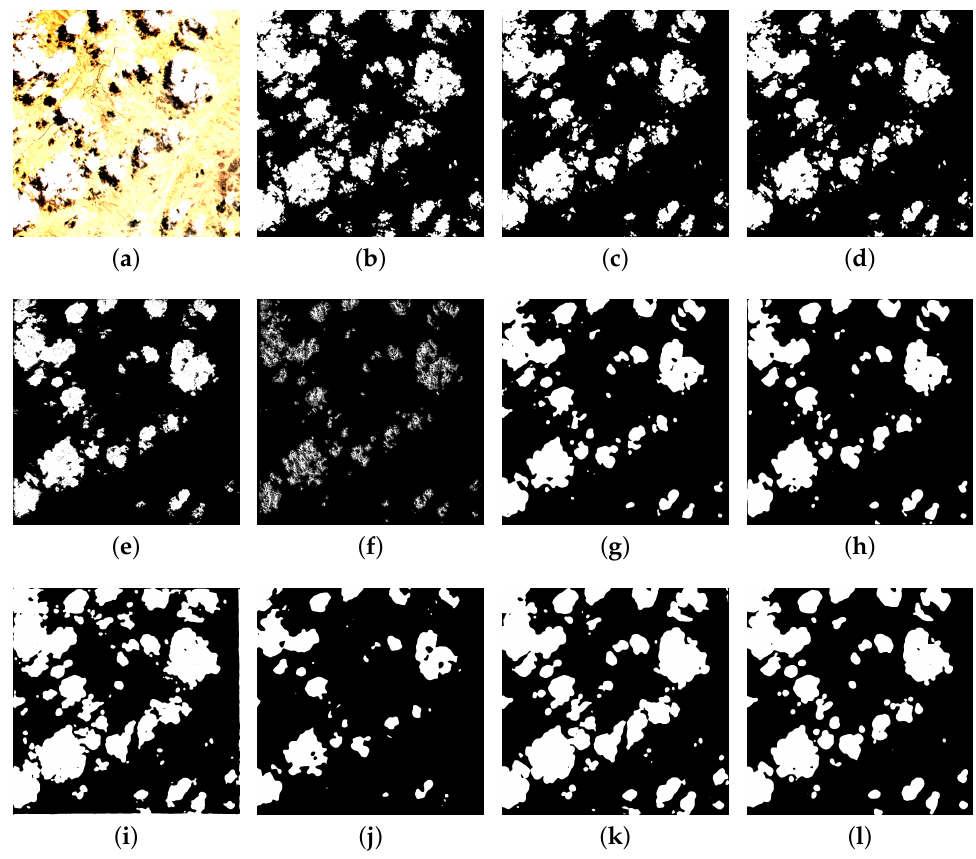
Figure 12. Binary detection of clouds on a patch of an S05 VEN µ S tile from various architecture settings: ( a ) RGB representation of a patch of an S05 VEN µ S tile; ( b ) ground-truth mask; ( c )